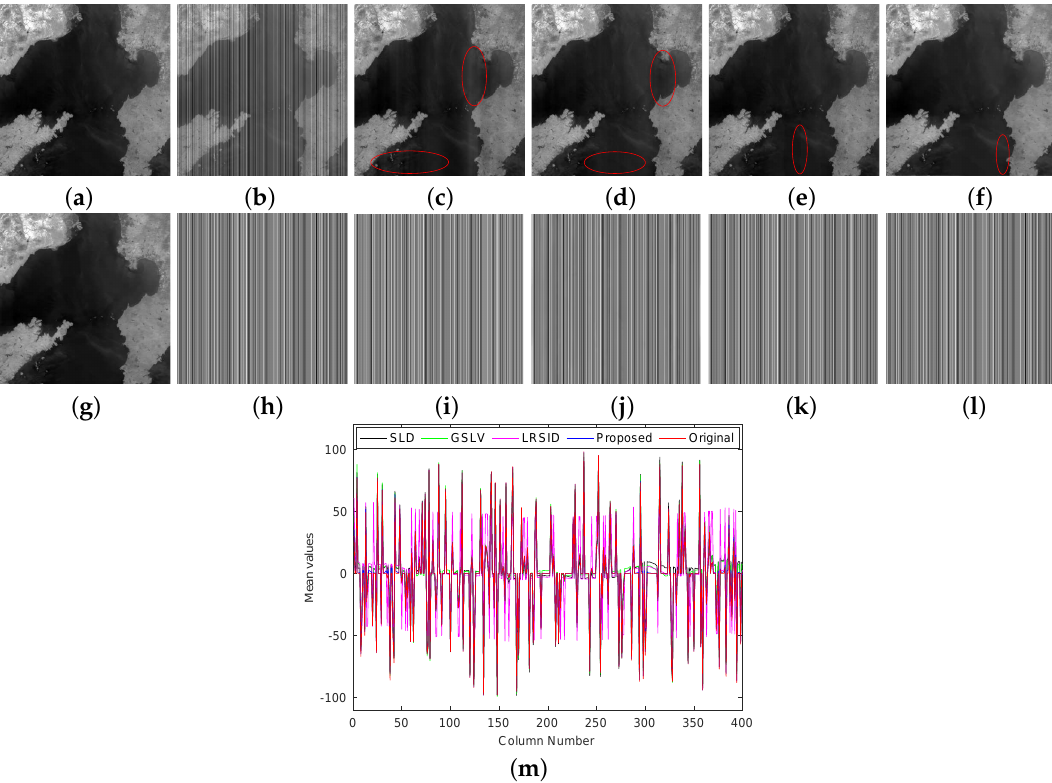
Figure 5. Destriping results with the simulated nonperiodic stripes case. ( a ) Original hyperspectral image; ( b ) degraded image with periodic stripes. Image component: ( c ) WAFT; ( d ) SLD; ( e ) GSLV; ( f ) LRSID; ( g ) the proposed method. Stripe component: ( h ) original added stripes; ( i ) SLD; ( j ) GSLV; ( k ) LRSID; ( l ) the proposed method. ( m ) mean value comparison between the stripes estimated by SLD, GSLV, LRSID, the proposed method, and the original one ( h